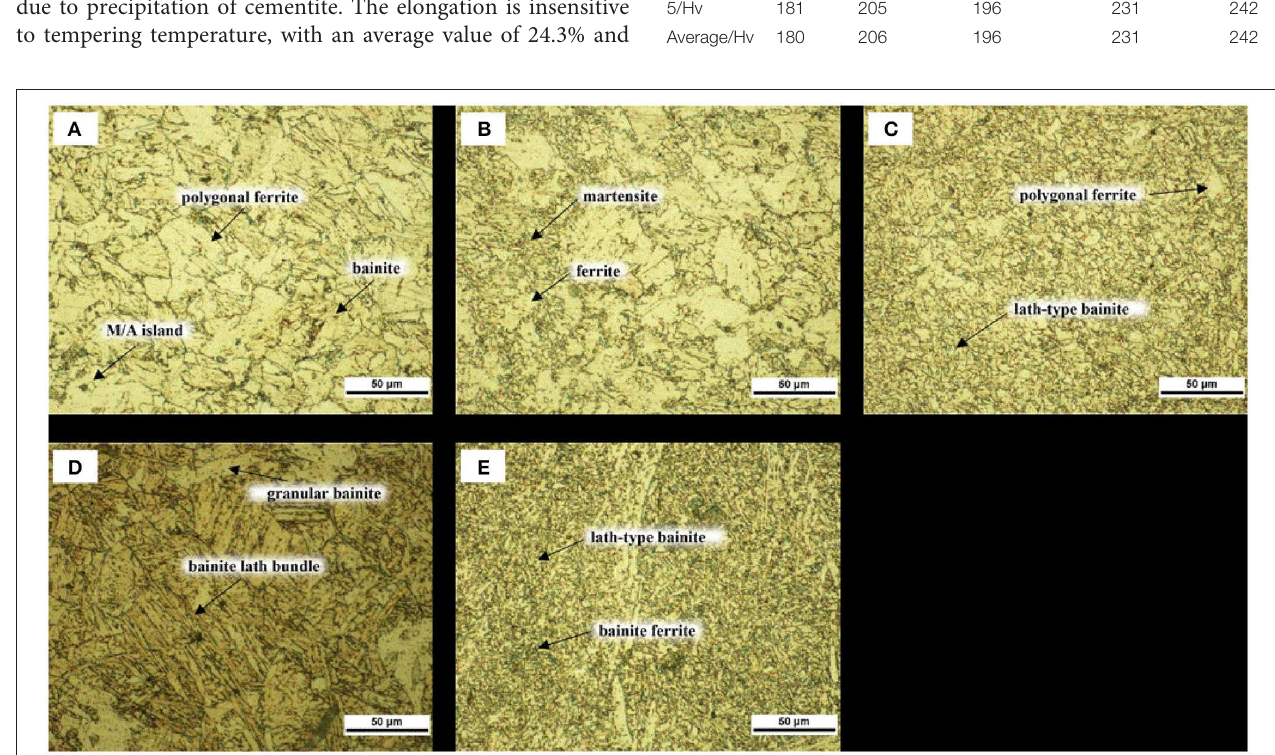
FIGURE 7 | Optical microstructure in the HAZ zone of CB10 steel with preheating to 50 ◦ C: (A) Base metal, (B) Intercritical zone, (C) Fine-grained heat-affected zone, (D) Coarse-grained heat-affected zone, (E) Fusion zone.